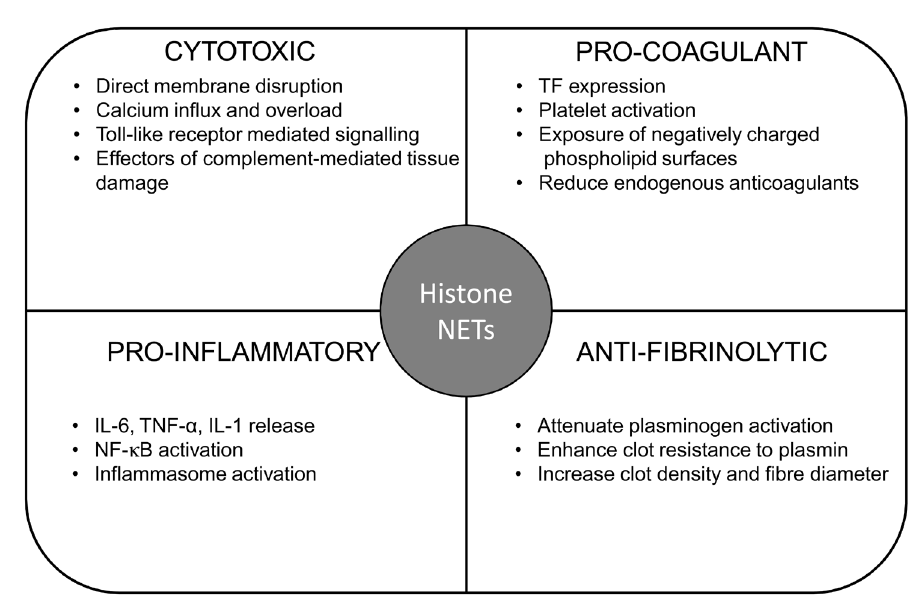
Figure 2. Functional consequences of circulating histones and neutrophil extracellular traps (NETs). Summary of pro-coagulant, anti-fibrinolytic, pro-inflammatory, and cytotoxic effects of histones and NETs. IL, interleukin; NF- κ B, nuclear factor-kappa B; TF, tissue factor; TNF- α , tumor necrosis